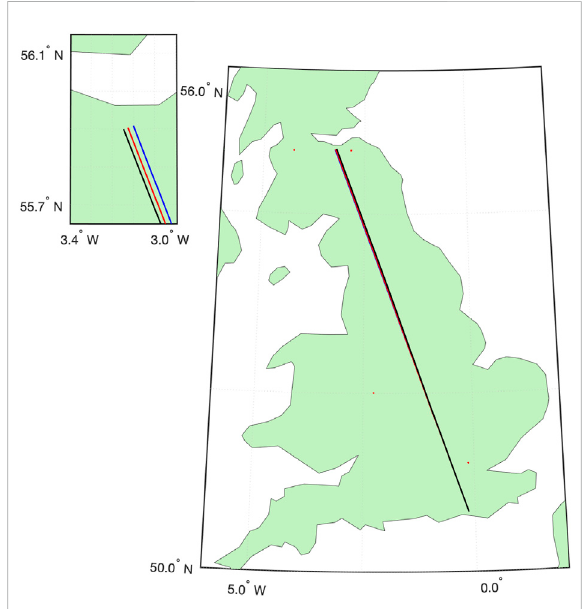
FIGURE 1 Map showing the true Brighton-Edinburgh trajectory (black), and an example of an uncalibrated aviation-grade INS solution (blue) and an aviation-grade INS with online calibration using a perfectly aligned set of perfect quantum sensors